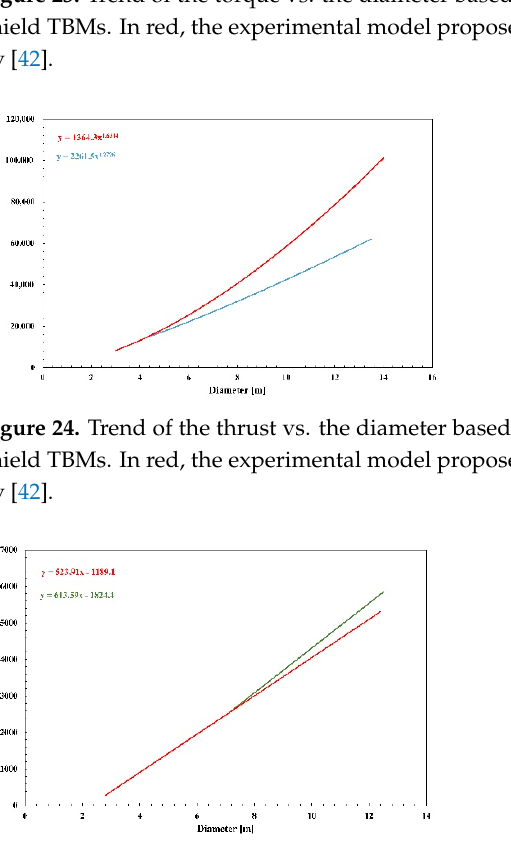
Figure 25. Trend of the power vs. the diameter based on data collected from the analysis of double shield TBMs. In red, the experimental model proposed in this study; in green, the model proposed by [43].